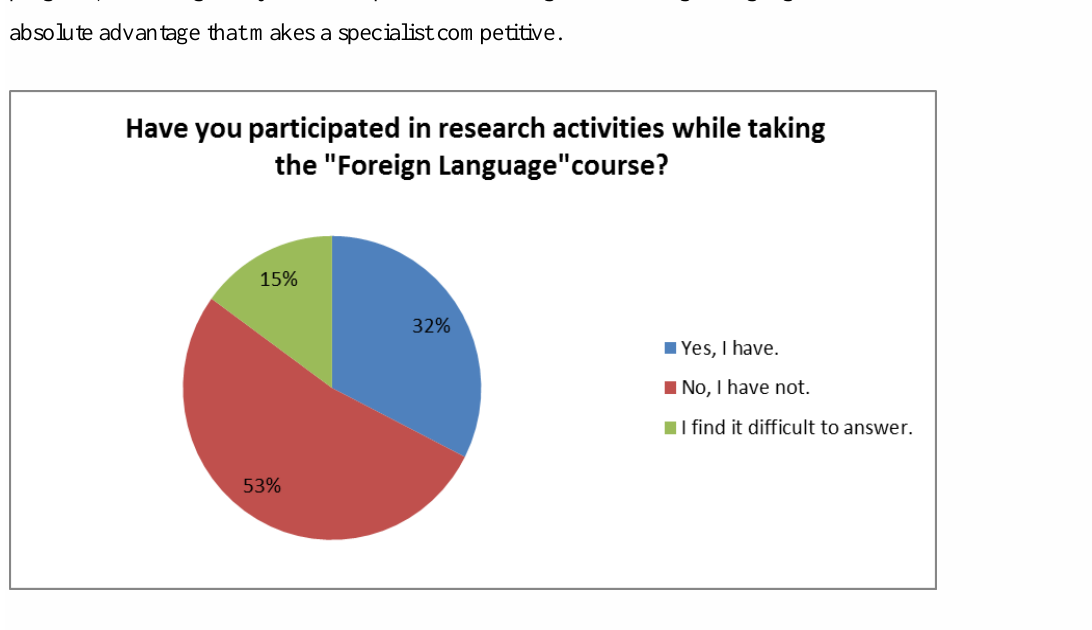
Figure 3. Participation in research activities while taking the “Foreign Language” course During the survey, it was found that most of the students were not involved in various studies while taking the “Foreign Language” course. Nevertheless, even 1-2-year Bachelor students can actively participate in various projects, scientific competitions, and conferences in a foreign language, especially in the context of digitalization of education, which presents a huge number of distance learning opportunities to share their opinions even “without leaving